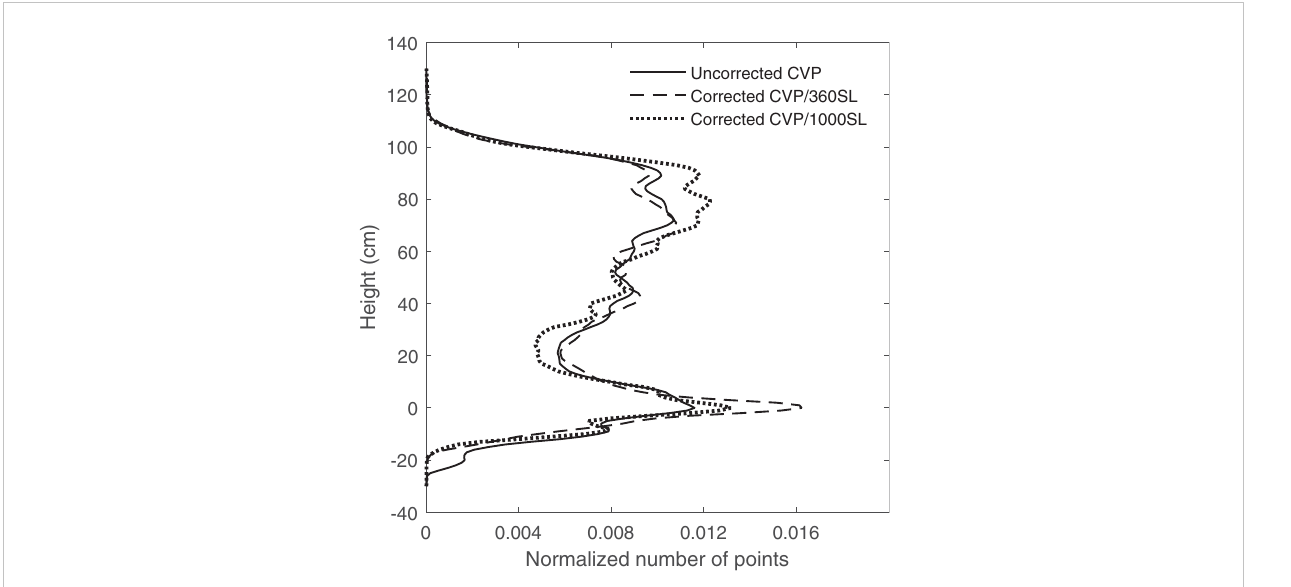
FIGURE 2 The effect of the different number of contiguous scan lines for applying height correction pre-processing on ground peak elevation on